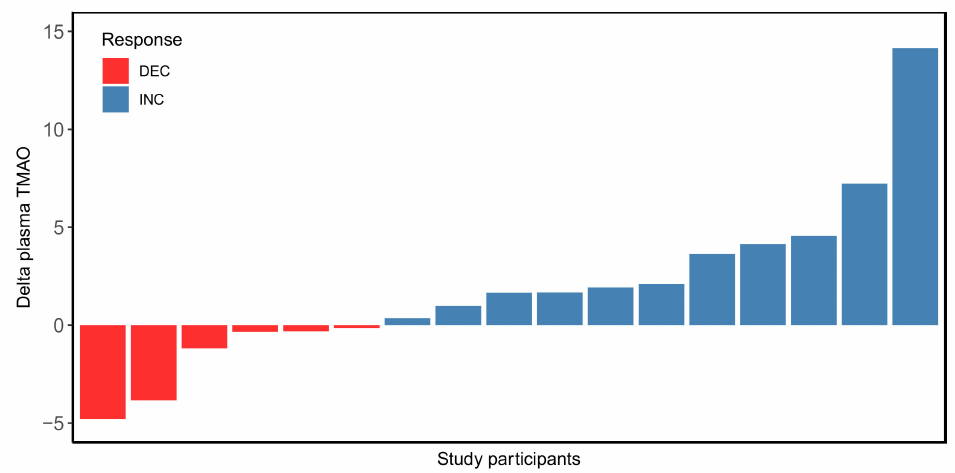
Figure 1. Individual plasma changes in TMAO levels after 8-week raspberry consumption. The y axis represents delta values in plasma TMAO in pre- versus post-Rb consumption. Each bar on the x axis represents one participant. DEC (red bars) and INC (blue bars) stand for TMAO decrease and TMAO increase subgroups,